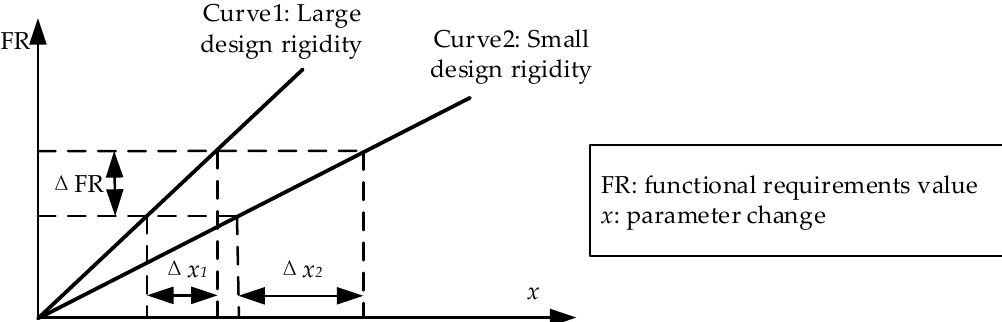
Figure 6. The relationship between the design rigidity of the scheme and functional requirements.